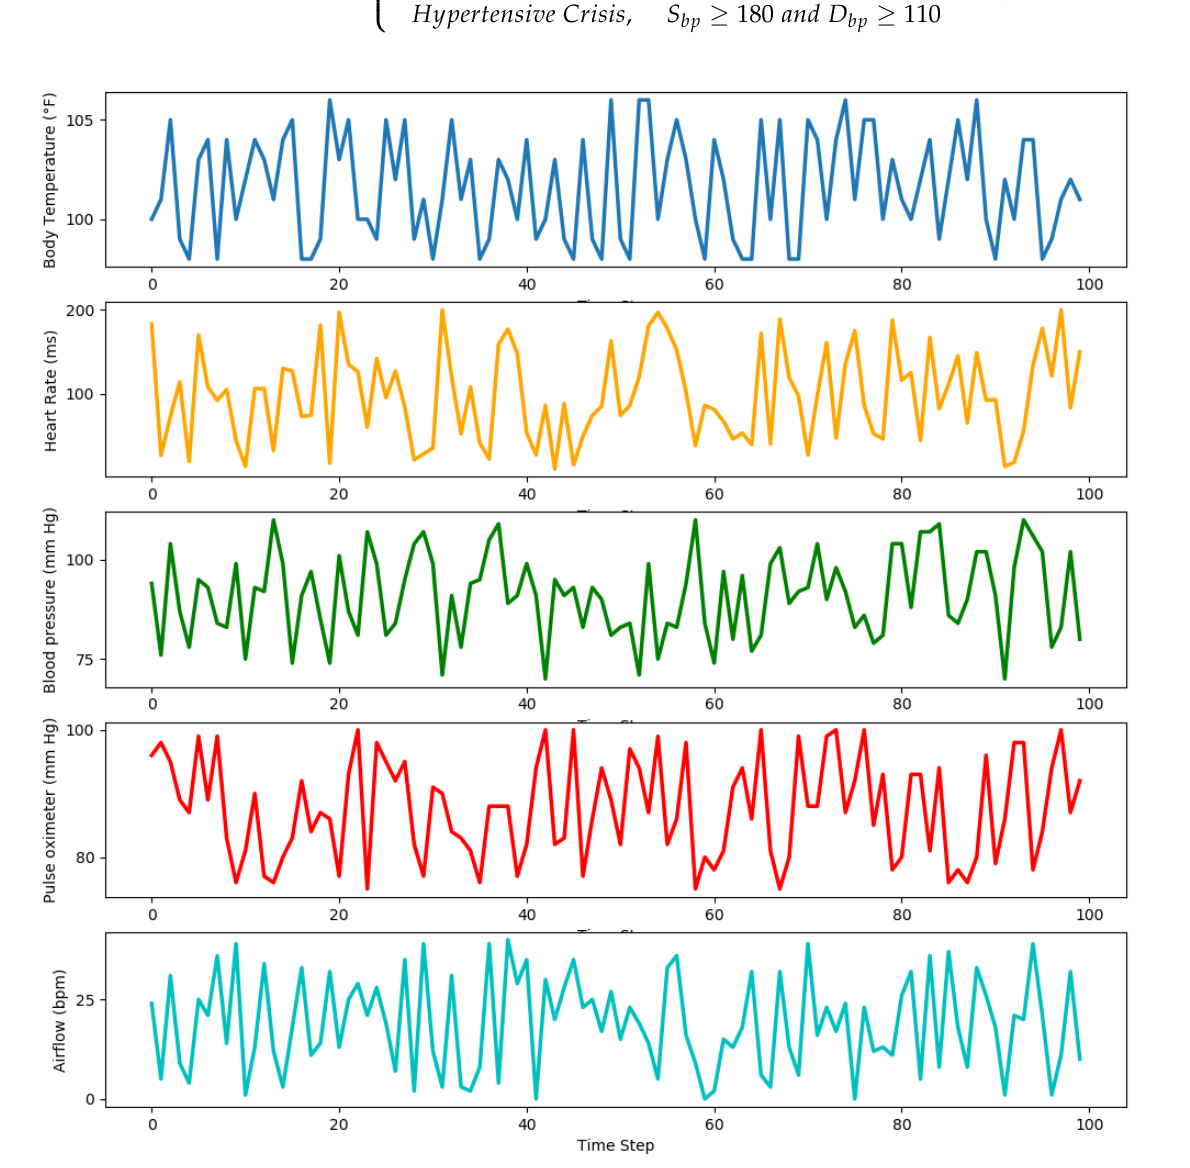
Figure 6. Visualization of healthcare tasks reading data using different sensors. Furthermore, SpO2 readings are also visualized to analyze pulse and oxygen quantity in patient blood. The normal SpO2 varies between 95% and 100%, as shown below the graph. Normal pulse oximeter readings usually range from 95 to 100 percent. Values under 90 percent are considered low. Abnormal values can be considered as a pulse oximeter is too low (<90). Moreover, readings of the respiration rate of patients are also